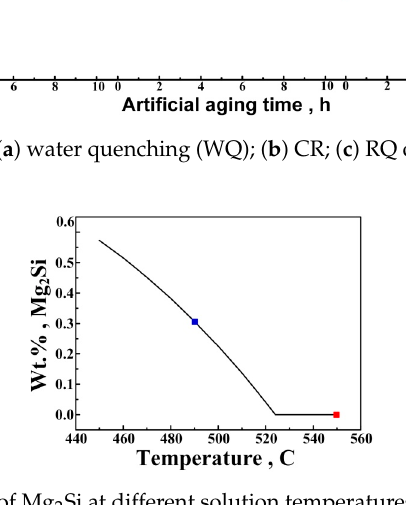
Figure 4. Equilibrium content of Mg 2 Si at different solution temperatures (calculated by JMatPro v10.2, Sente Software, Guildford, UK).